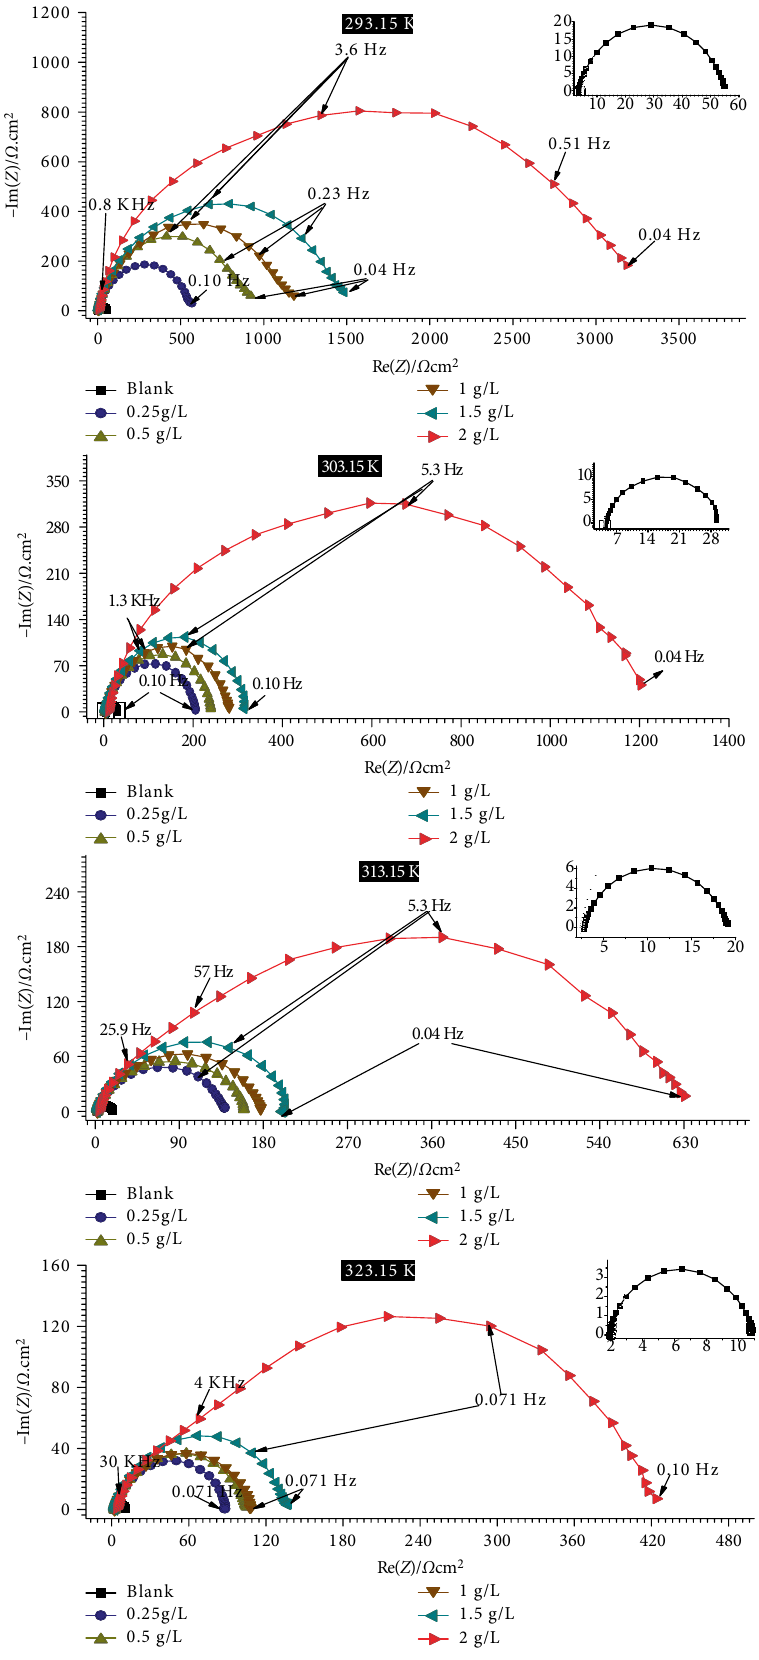
Figure 5: Nyquist plots obtained for C38 steel in 1 M HCl with different temperatures and inhibitor